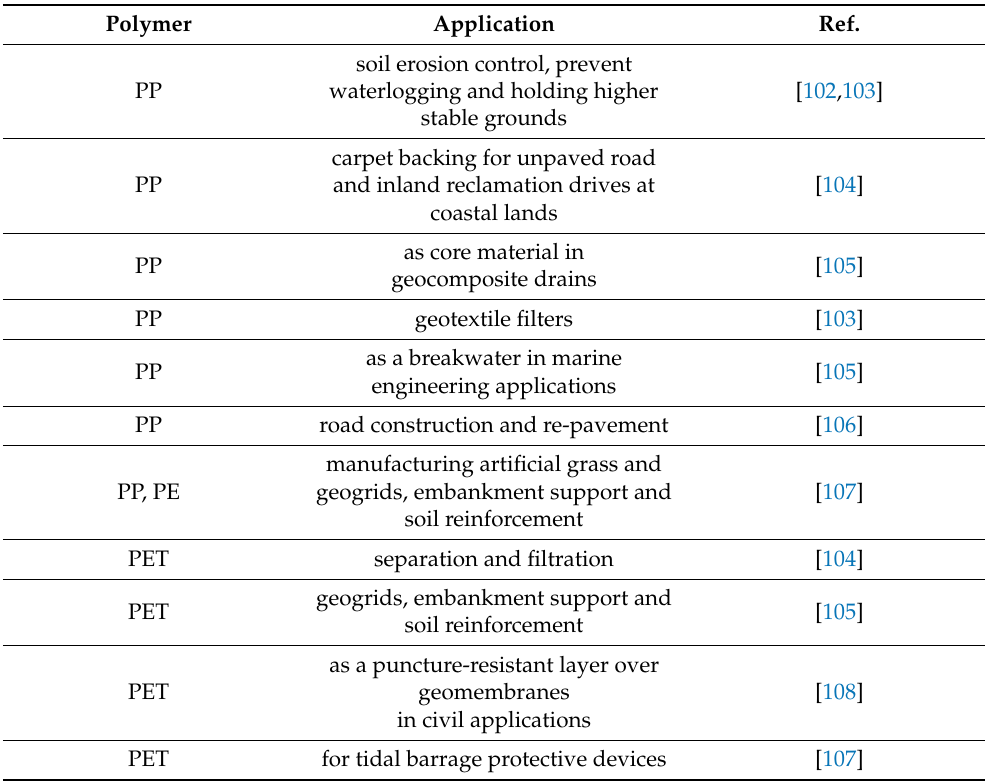
Table 1. Applications of synthetic polymers in